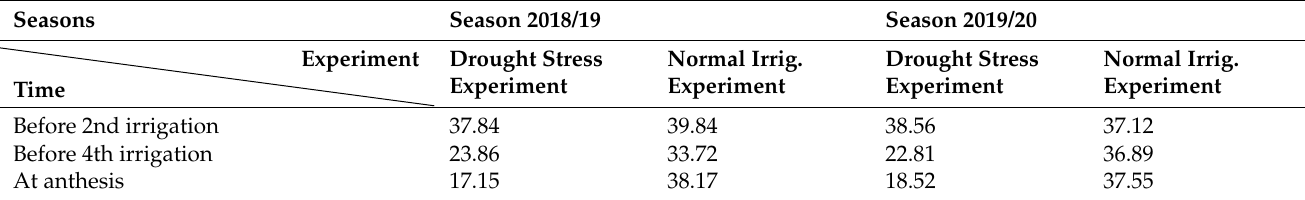
Table 6. The soil moisture percentage at 30 cm depth, estimated from a mixed sample representing different areas of the experimental